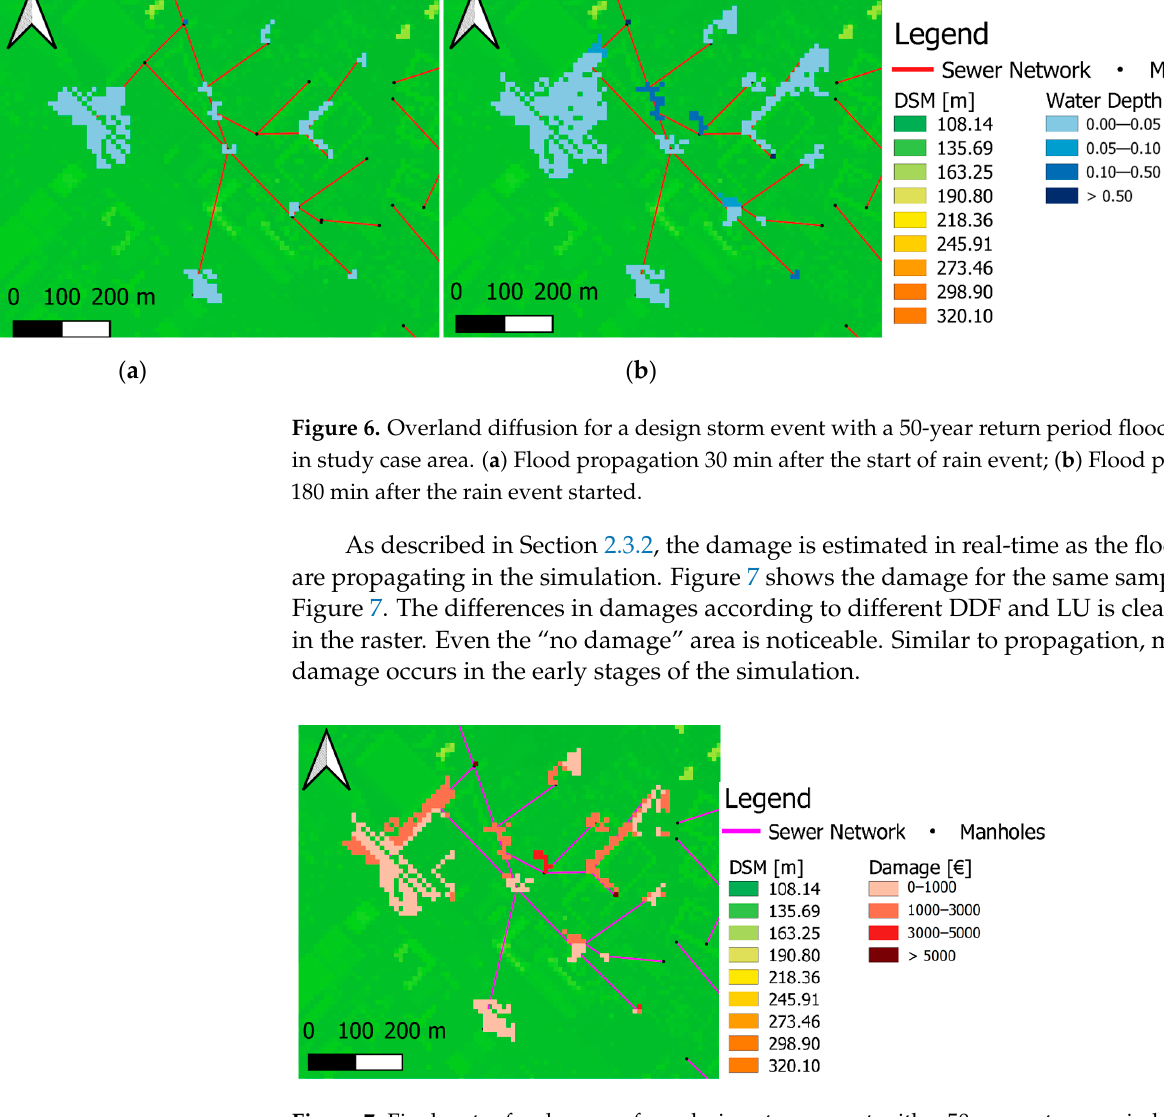
Figure 5. Total flood inundation extents and depths for a design storm event with a 100-year return period.